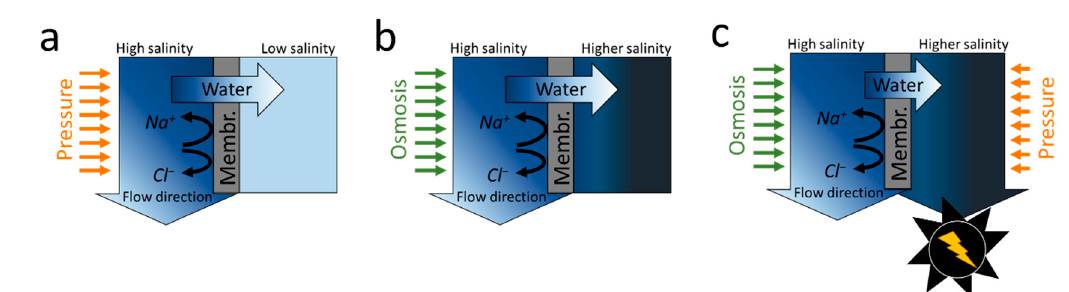
Figure 1. Schematic and working principle of ( a ) pressure-driven (RO) or ( b ) osmotic-driven (FO) membrane processes. ( c ) Membrane-based renewable energy production process (PRO) using a turbine (black) driven by pressurized water flow.